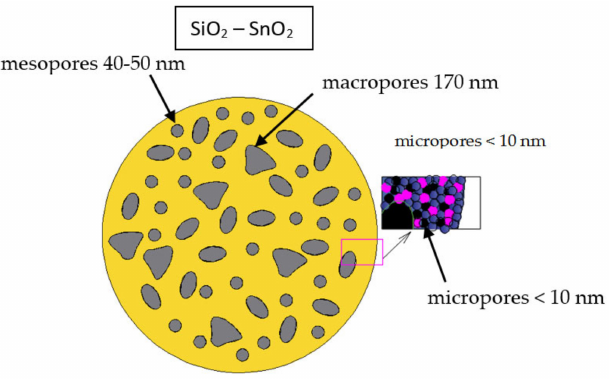
Figure 20. Hierarchical model of the formation of two-component porous nanocomposites.